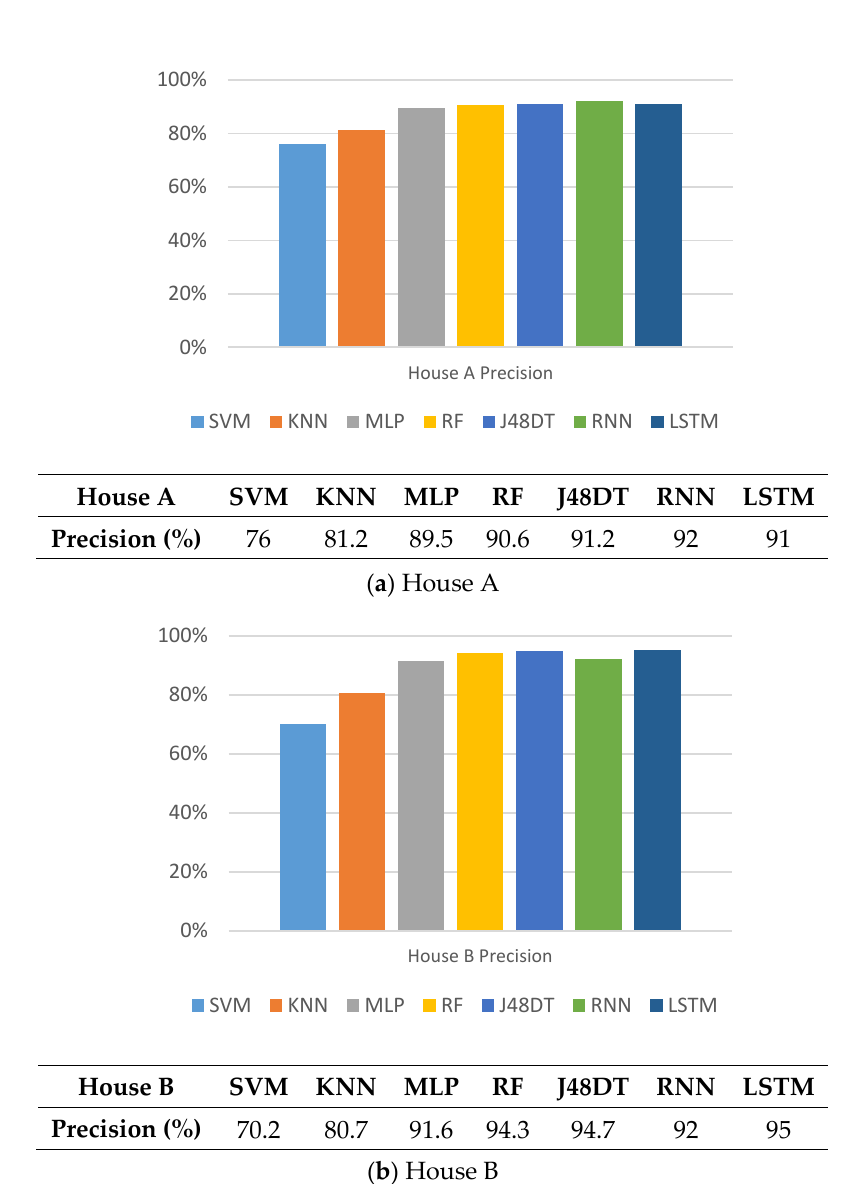
Figure 5. Comparison on precision of different methods.